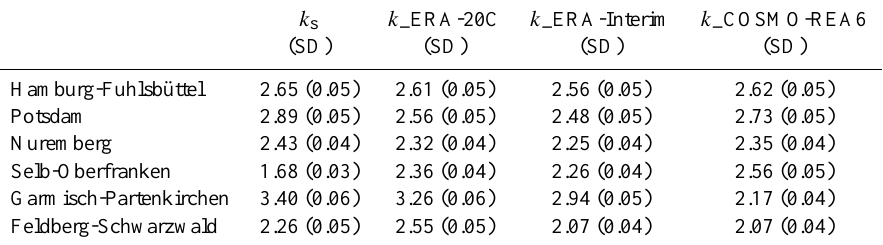
Table 1. Weibull parameters k (shape) derived from selected station daily mean wind observations ( k s ), and from ERA-20C, ERA-Interim, and COSMO-REA6 interpolated grid cells matching the station locations, together with their 1 σ standard deviations (SD).